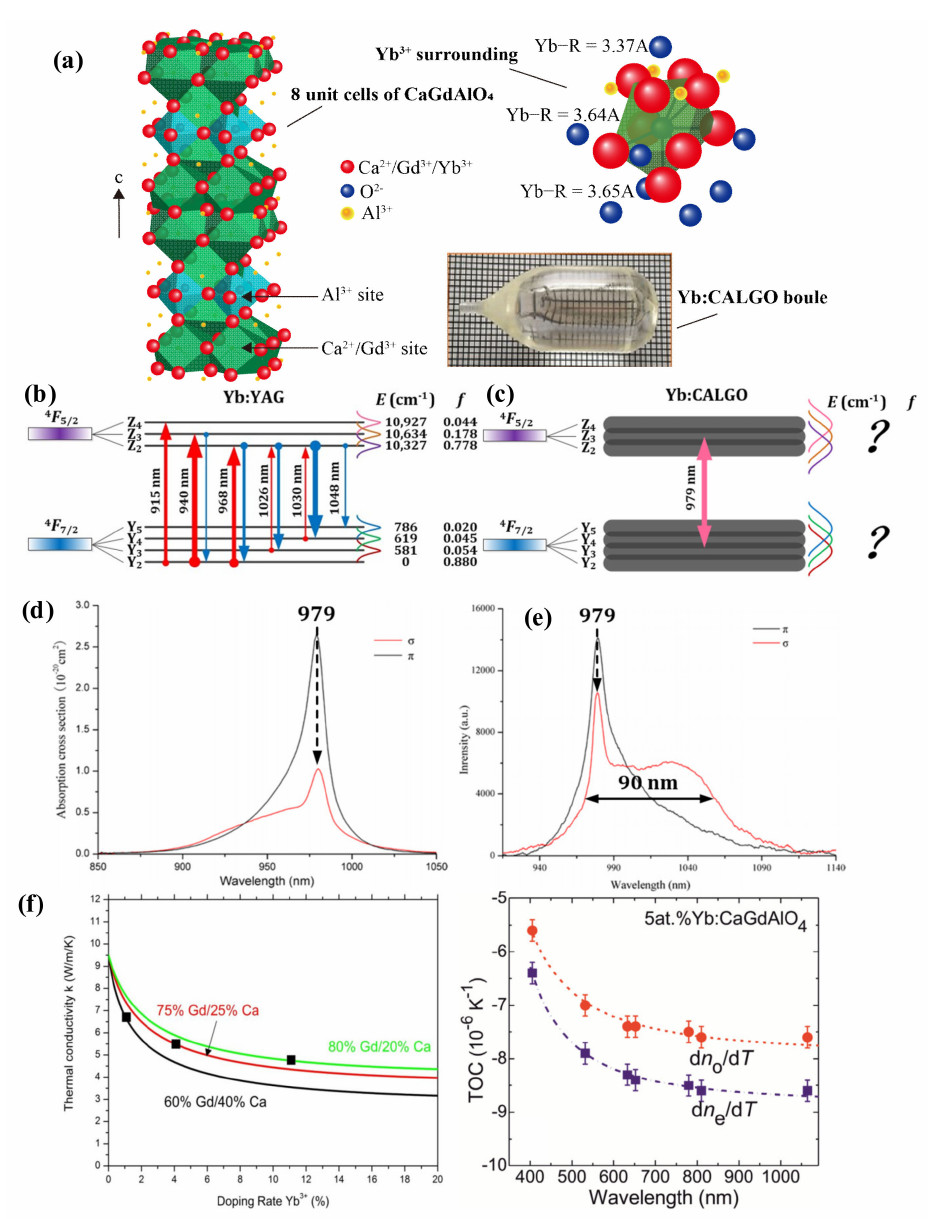
Figure 1. ( a ) Eight unit cells of CaGdAlO 4 (left), local surrounding of Yb 3+ in CALGO structure (upper right) and appearance of Yb:CALGO (lower right). Energy band structures of ( b ) Yb:YAG and ( c ) Yb:CALGO. The absorption ( d ) and emission ( e ) cross-sections of Yb:CALGO [28]. ( f ) Thermal conductivity versus doping rate of Yb 3+ for different Gd 3+ /Ca 2+ occupation site [29] and thermo-optic coefficient (TOC) versus wavelength in a 5 at. % Yb:CALGO for the ordinary light and extraordinary light [37]. ( a ) The unit cell picture and local structure picture are redrawn based on ref. [26] and ref. [55], respectively. The Yb:CALGO boule picture is permitted for reuse by School of Crystal Materials (State Key Laboratory of Crystal Materials) of Shandong University, Group of Prof. Xutang Tao. ( d , e ) Reprinted with permission from ref. [28], IOP Publishing. ( f ) Left, reprinted with permission from ref. [29], SPIE. ( f ) Right, reprinted with permission from ref. [37], ©The Optical